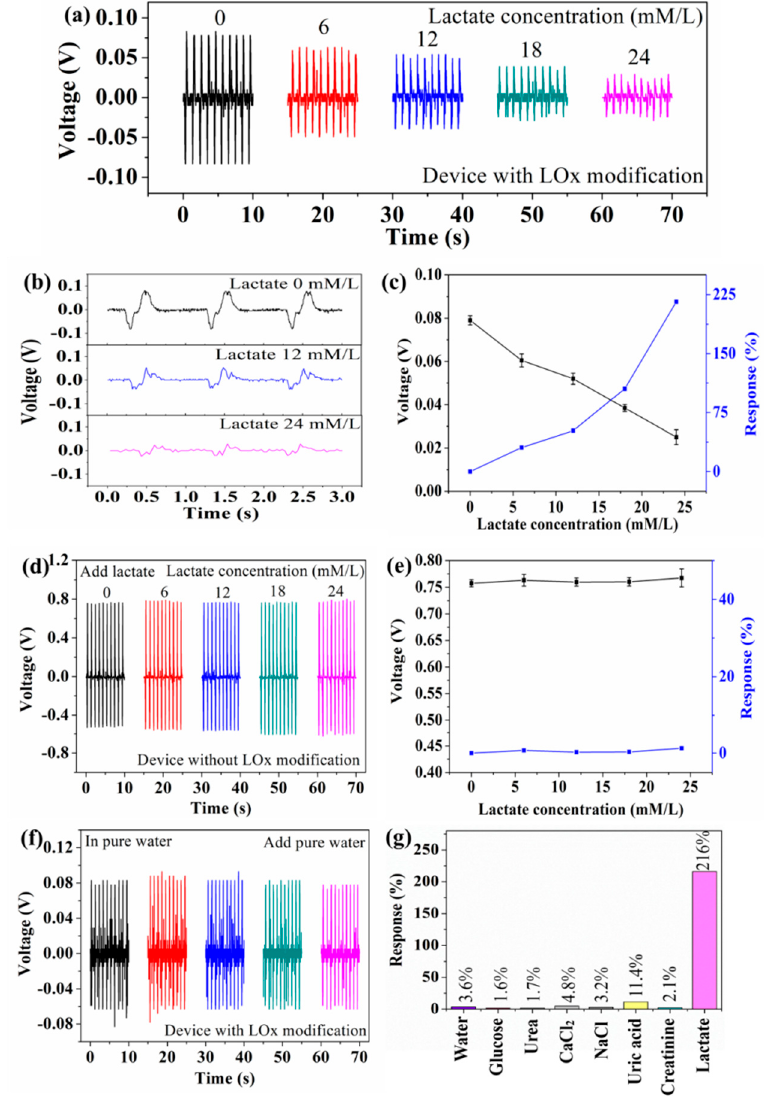
Figure 4. Self-powered piezoelectric-biosensing textiles for detecting lactate concentration in aqueous solution. ( a ) The output piezoelectric voltage of the device (with LOx modification) at different lactate concentrations. ( b ) The details of the signal. ( c ) The response of the device (with LOx modification) against different lactate concentrations. ( d ) The output piezoelectric voltage of the device (without LOx modification) at different lactate concentrations. ( e ) The response of the device (without LOx modification) against different lactate concentrations. ( f ) The output piezoelectric voltage of the device upon adding pure water. ( g ) The selectivity of the self-powered piezoelectric-biosensing textiles.